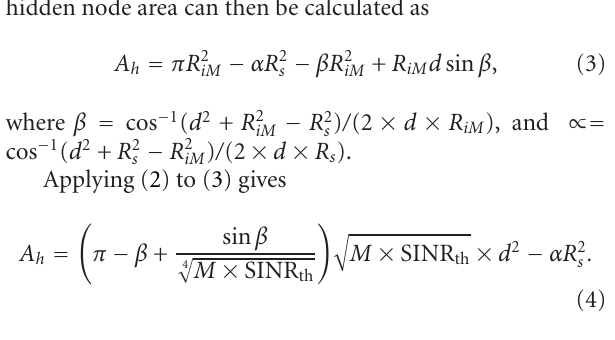
(cid:3) SINR th , the